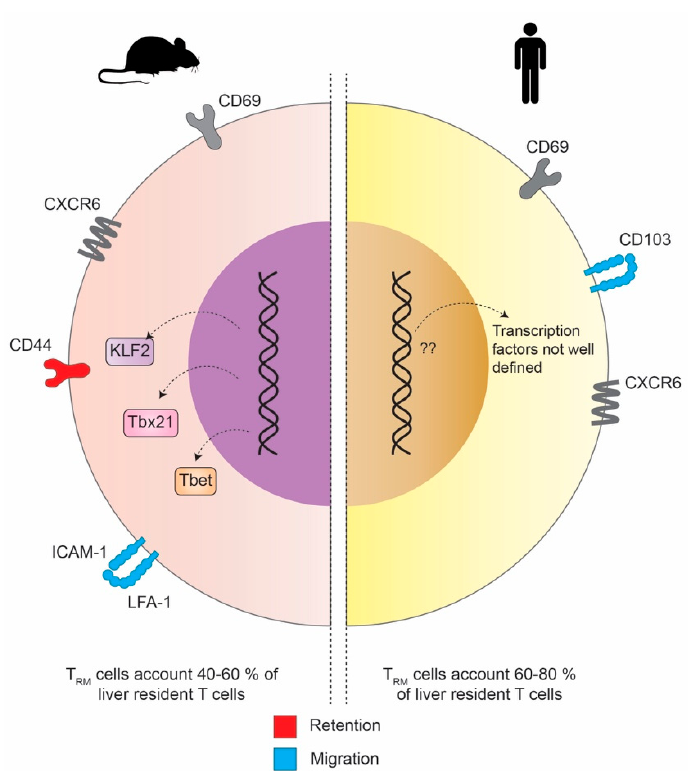
Figure 3. T RM cells can be detected in mice and humans. In both species, T RM cells express CD69 and CXCR3. However, in humans, one population of T RM cells expresses CD103 + , while CD103 surface expression is not found in mice T RM cells. On the other hand, mice T RM cells express CD44, which mediates their liver retention and ICAM-1 / LFA-1 responsible for T RM cell migration within the liver. The frequency of T RM cells within the resident T cell compartment varies between mice and humans. Some studies have described that mice T RM cells express the transcription factors Tbet, Tbx21 and KLF2, but the transcription factors upregulated by human T RM cells are not defined